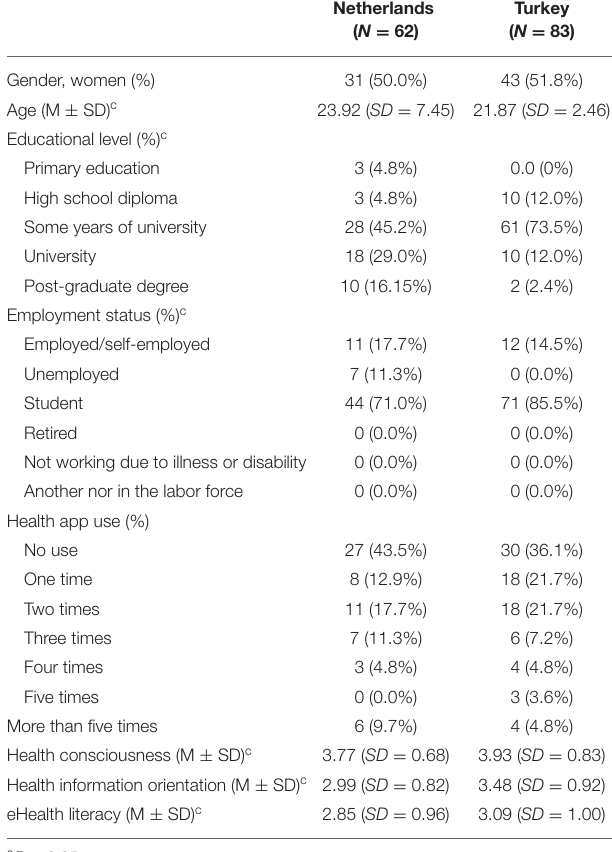
TABLE 1 | The attributes and levels selected for the DCE.